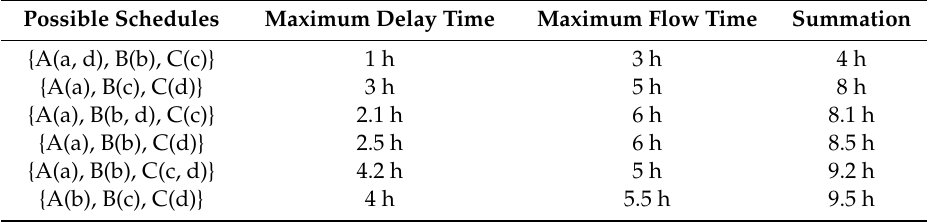
Table 5. Example results obtained in the third step of the proposed scheduling